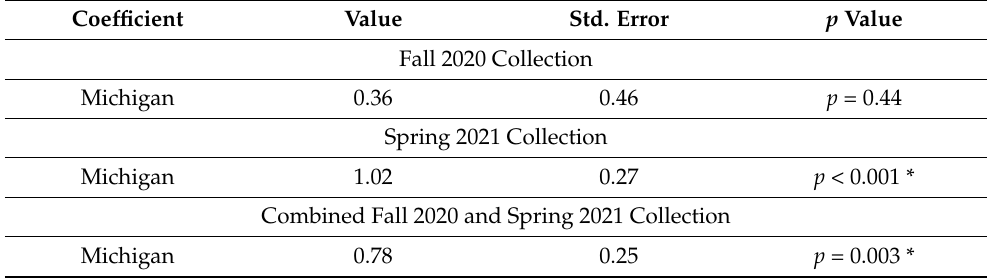
Table 5. GLS results (gls(log(Standardized Tip Abundance)~Provenance)) of root tip abundance across trees of different provenance for each collection and for combined collections data. Mean root tip abundances per gram of dry root mass varied significantly between Maine and Michigan trees when collections data were combined and in the spring 2021 collection